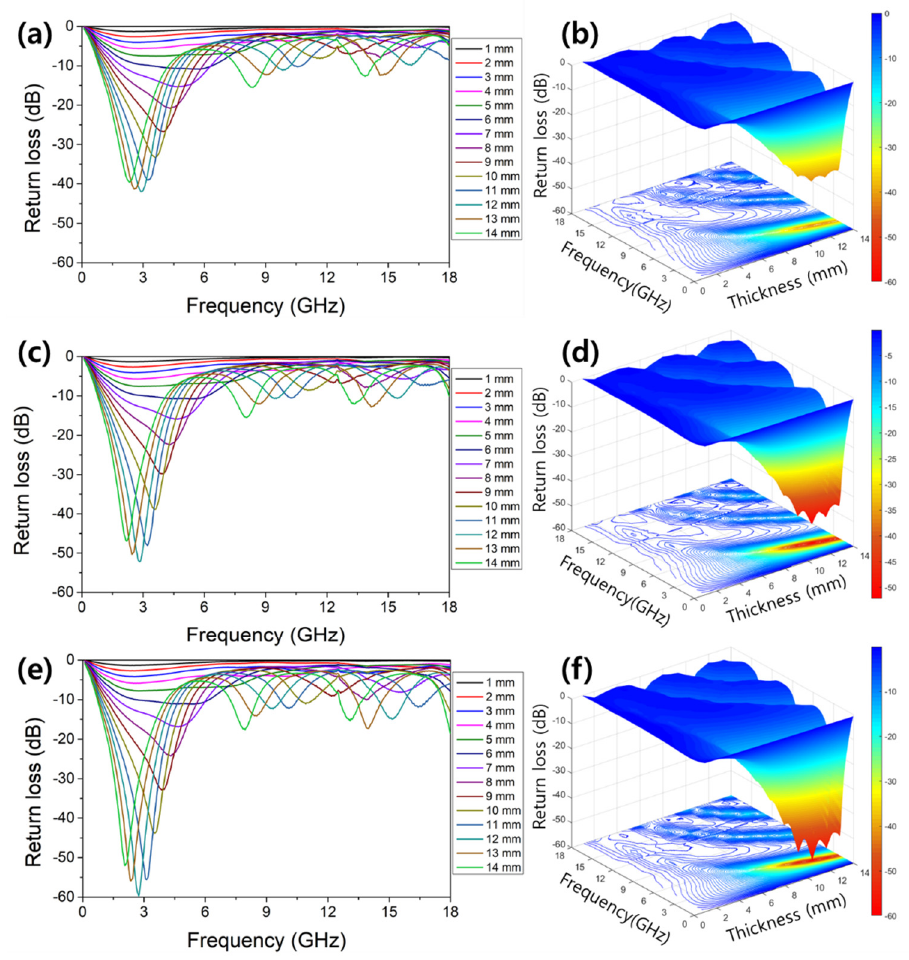
Figure 6. Frequency and thickness dependences of the reflection loss of NZF: ( a , b ) reflection loss graphs, 3D map, and contour of sample A, ( c , d ) reflection loss graphs, 3D map, and contour of sample B, ( e , f ) reflection loss graphs, 3D map, and contour of sample C.